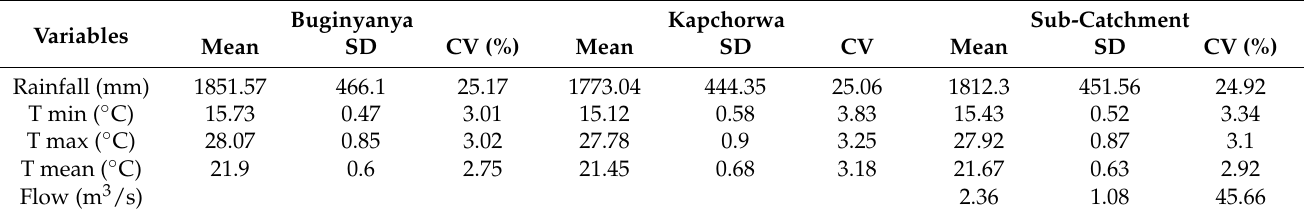
Table 4. Annual variability of rainfall; minimum, maximum, and mean temperature (1981–2015); and flow (1998–2015).